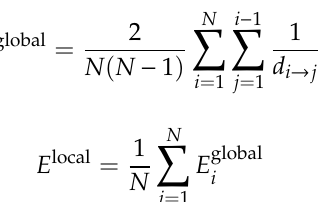
e ffi ciency. There are two types of network e ffi ciency: global e ffi ciency and local e ffi ciency. The global e ffi ciency is the e ffi ciency of the entire